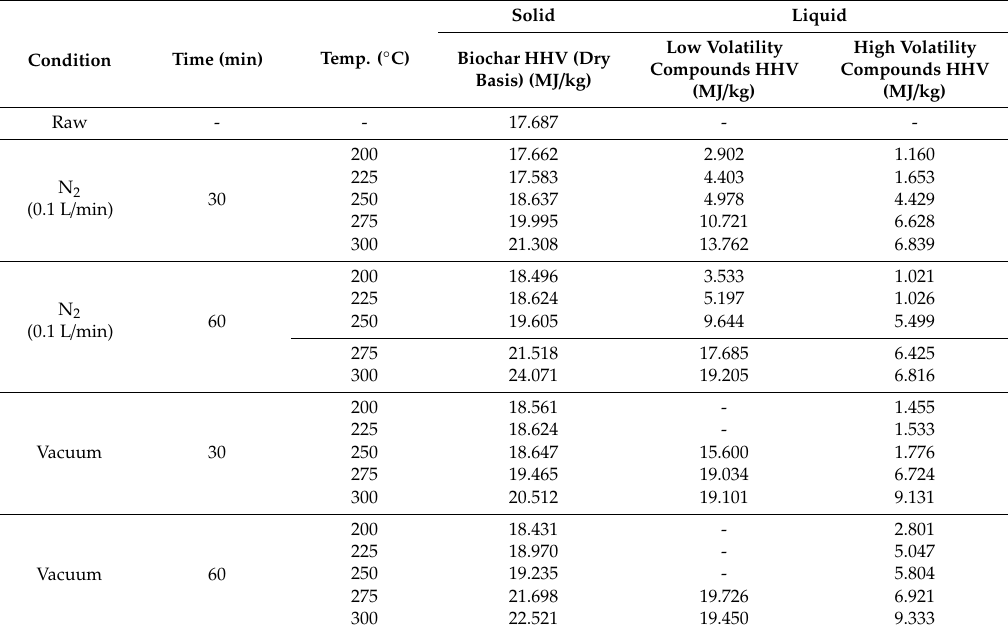
Figure 5. Profiles of the HHV of torrefied wood sawdust in vacuum and nitrogen systems with different temperatures and times. Table 5. HHVs of untreated and torrefied